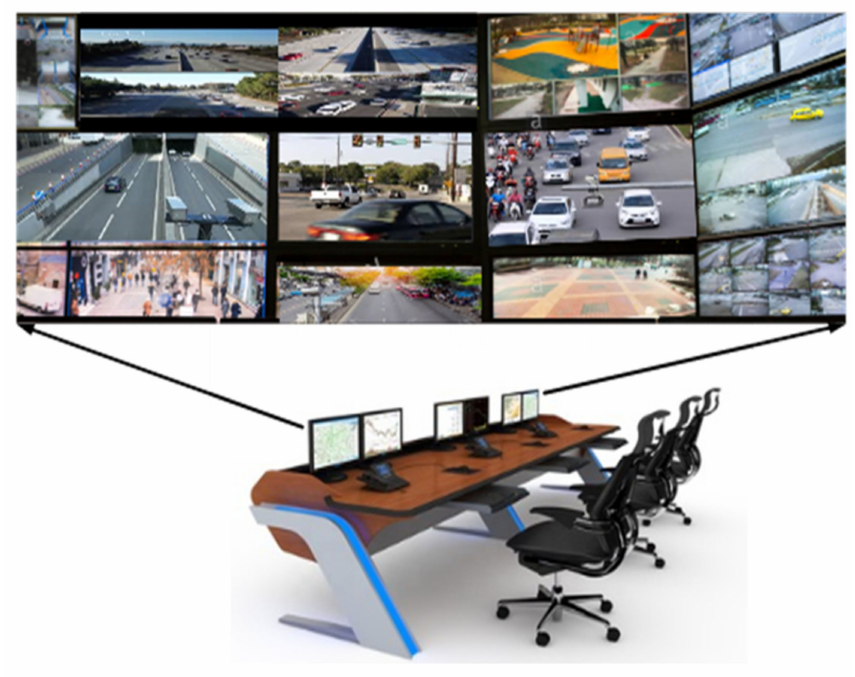
Figure 2. Shows view of manually traffic monitoring at control